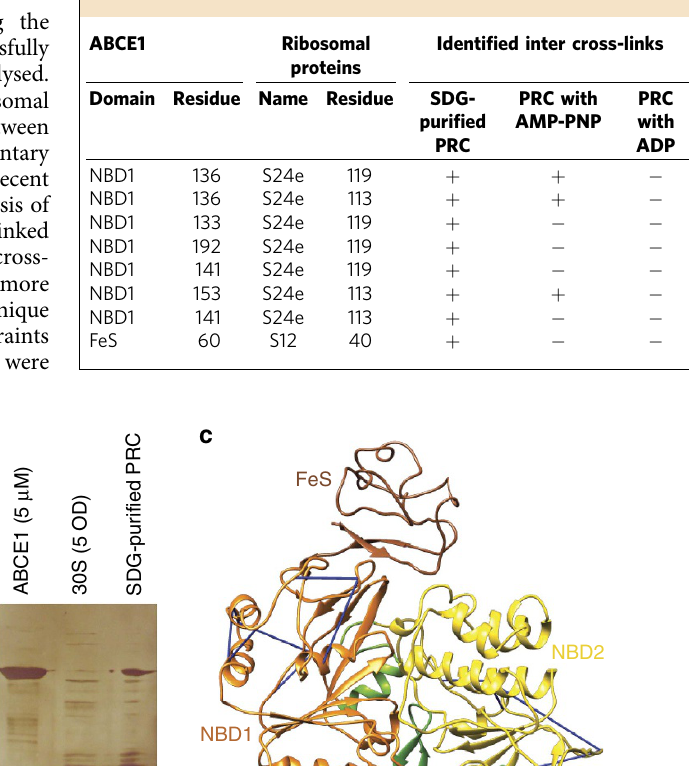
Table 1 | Identified inter cross-links between ABCE1 and ribosomal